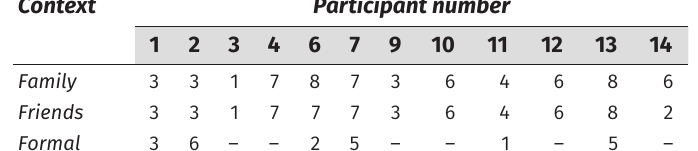
Table 2: Degree of influence of Asturian (none to 10) in the daily speech of each participant in three different contexts: With family, with friends, and in more formal contexts (work, university,